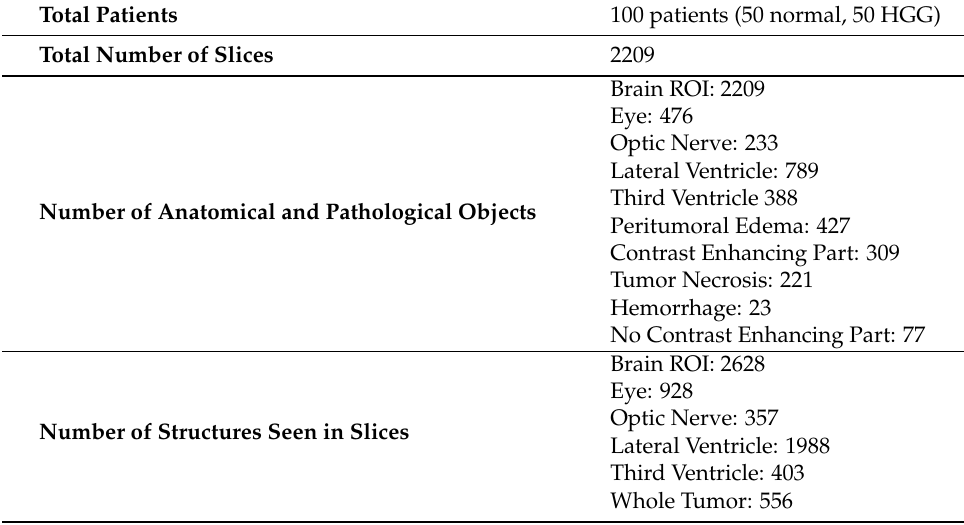
Table 2. Gazi Brains 2020 Dataset